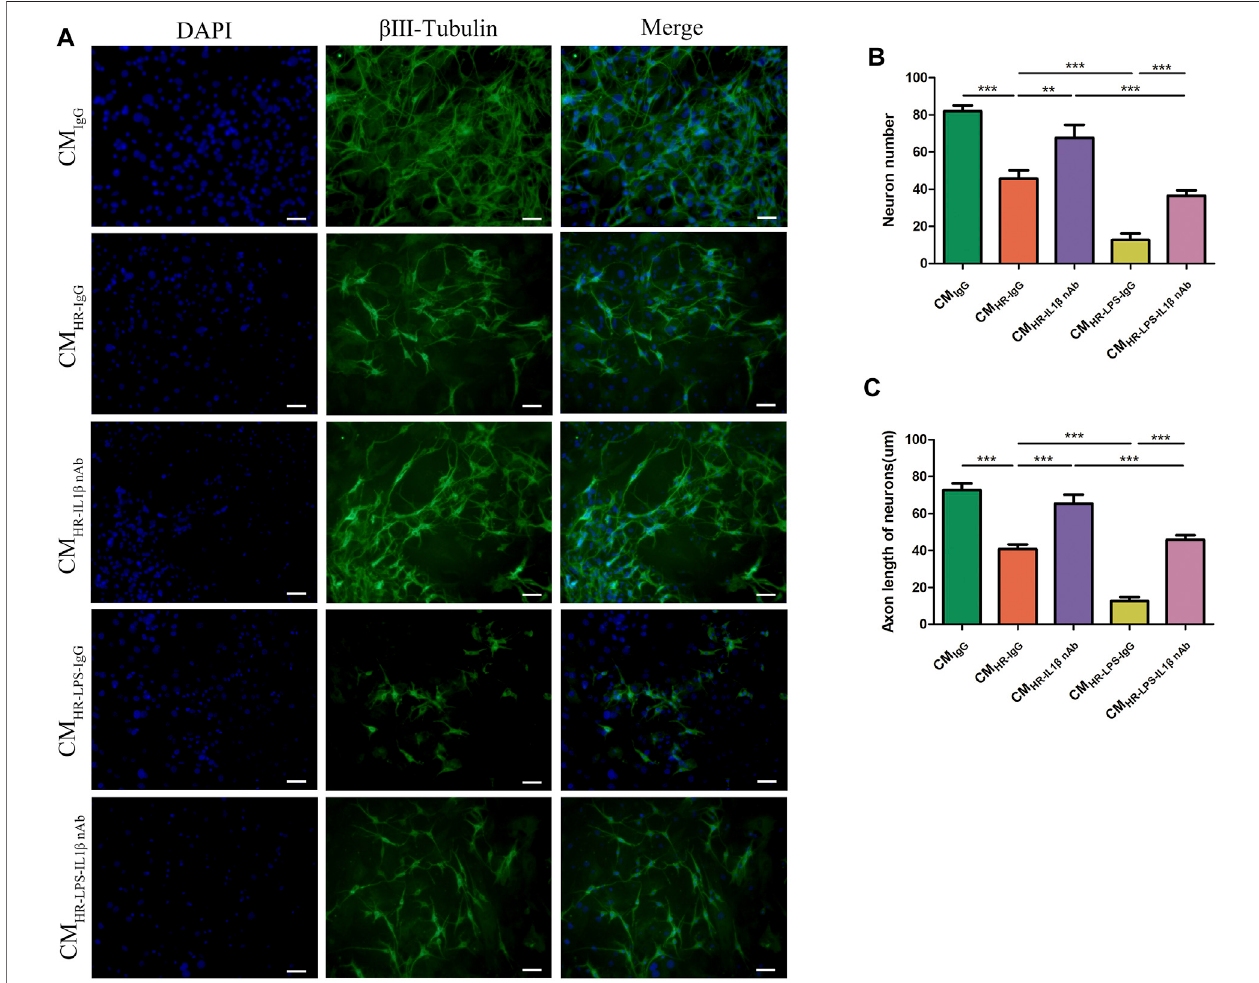
FIGURE5| NeutralizationofIL-1 β amelioratedthemyentericneuroninjury invitro .MyentericneuronswereincubatedwithPMCMwithorwithoutthepretreatment of LPS and/or IL-1 β -neutralizing antibody under normal and HR conditions. (A) Representative photographs of immuno fl uorescent staining of β Ⅲ -tubulin (green) and DAPI (blue). Scale bar = 50 μ m. N = 5 /group. (B,C) Quantitative analyses of the number of neurons and the length of axons. Six randomly captured images per animal were analyzed for each group. N = 5 /group. Values are mean ± SEM , * p < 0.05, ** p < 0.01, and *** p < 0.001 according to ANOVA with the Newman – Keuls test.